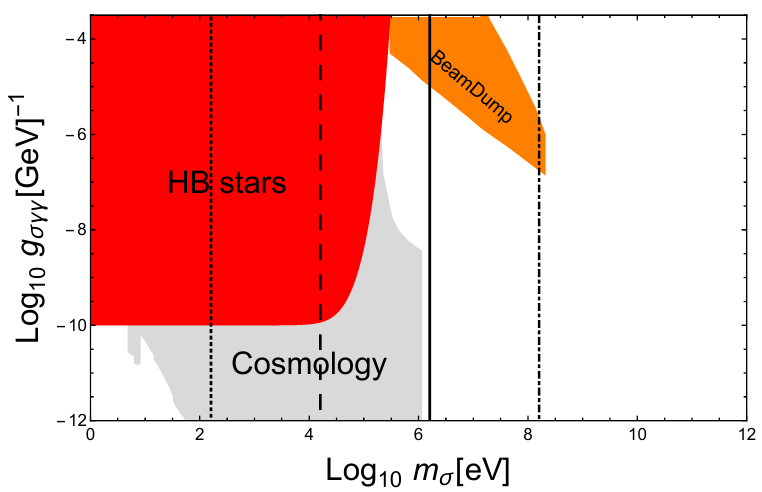
Figure 11. The open light radion window in white. The radion masses indicated by vertical lines correspond to vacuum energy contributions of (cid:0) (10 MeV) 4 (dotted), (cid:0) (100 MeV) 4 (dashed), (cid:0) (1 GeV) 4 (solid) and (cid:0) (10 GeV) 4 (dot-dashed) in a benchmark